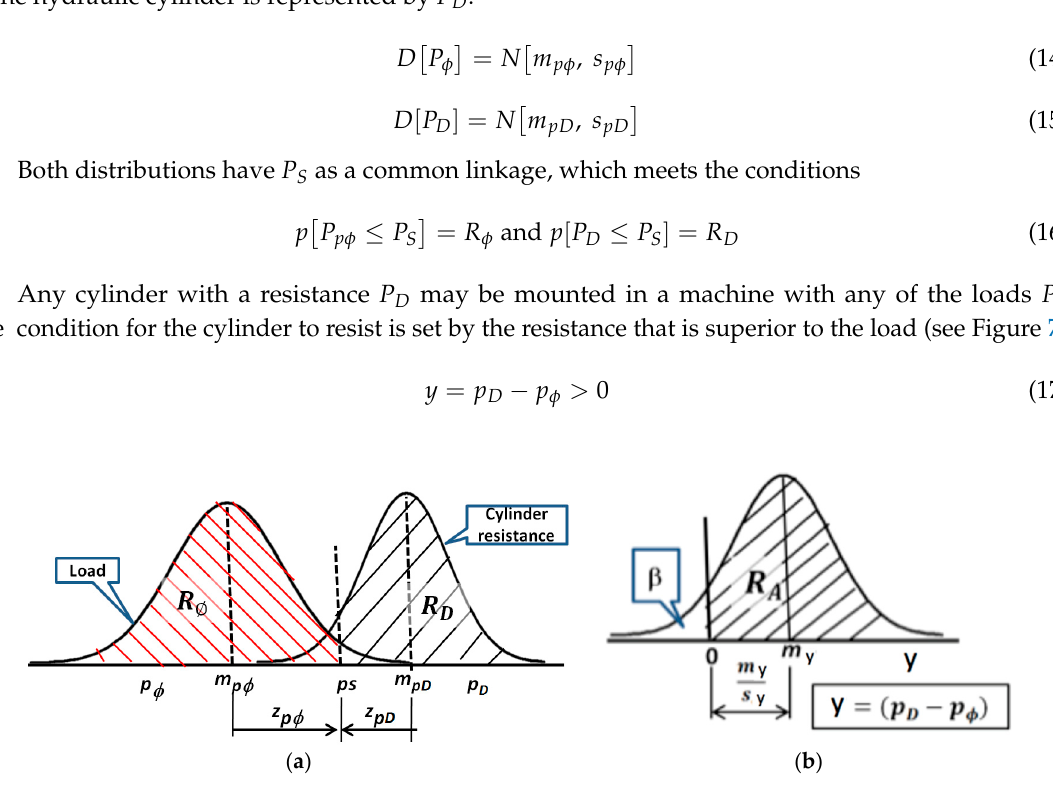
Figure 7. Cylinder mounted in a machine with any of the loads: ( a ) Load variability and structural variability functions; ( b ) At the end of the life will not fail more than β % of cylinders.